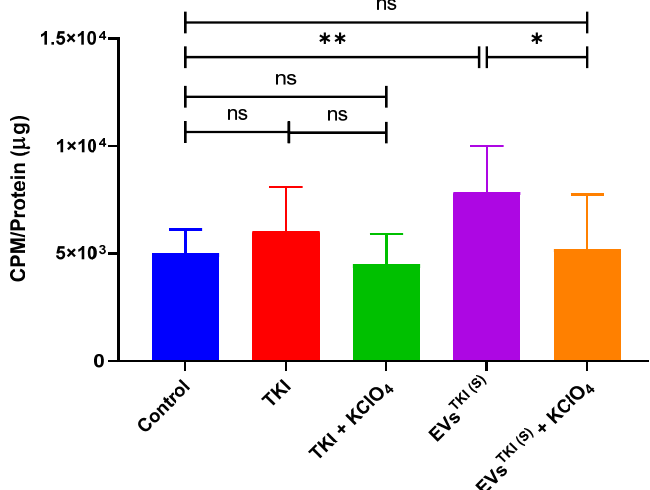
Figure 7. 125 I accumulation in ATC cells after treatment with TKI or EVs TKI(S) . The SW1736 cells were exposed to TKI (0.5 µg/mL) or EVs TKI(S) (0.5 µg/mL) for 72 h and were subsequently incubated with 37 kBq carrier-free 125 I and 10 µm/L sodium iodide at 37 °C for 30 min. 125 I uptake after the TKI treatment and that after the EVs TKI(S) treatment were compared with the 125 I uptake after the control treatment (DMSO). KClO 4 was used as a competitive inhibitor of NIS ( n = 6). Data are expressed as mean ± SD. ** p < 0.01, * p < 0.05 (by Student’s t- test).